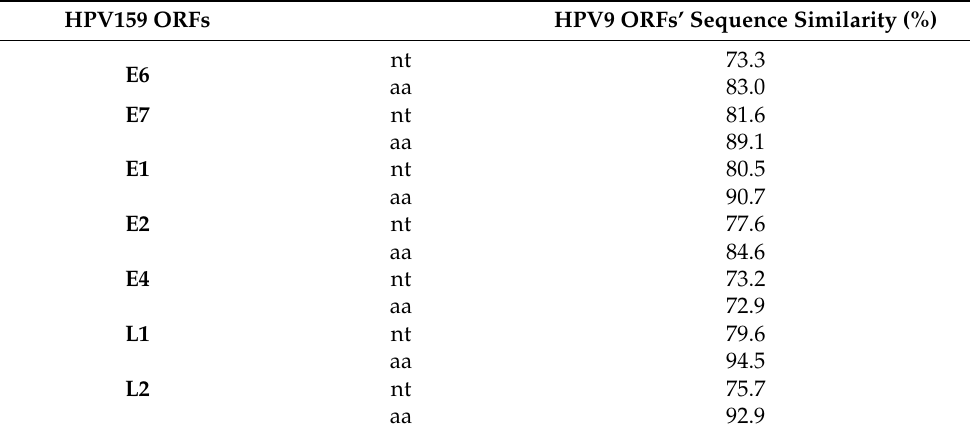
Table 1. Percentage similarity between individual viral genes of HPV159 and the phylogenetically most related HPV type: